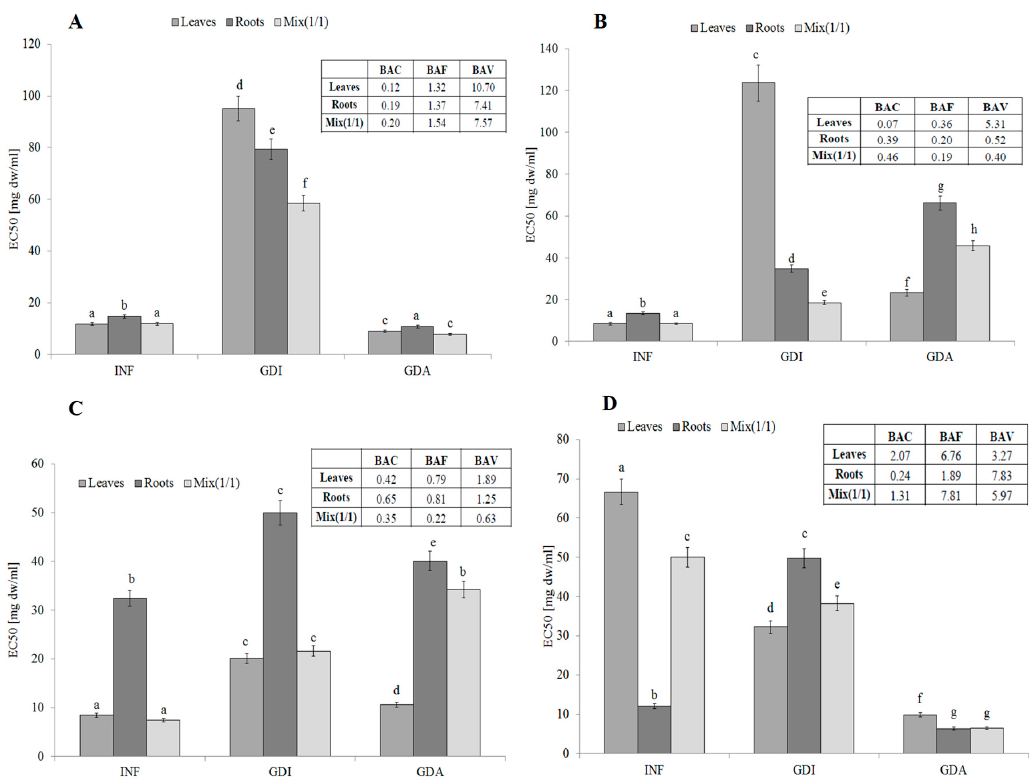
Figure 1. Antioxidant activity, potential bioaccessibility, bioavailability and bioefficiency of low-molecular antioxidants of leaves and roots of S. aloides . ( A )—antiradical activity, ( B )—ferric reducing power, ( C )—inhibition of linoleic acid peroxidation, ( D ) metal chelating activity. INF—infusions, GDI—gastrointestinally digested extracts, GDA—samples after simulated absorption; BAC—the